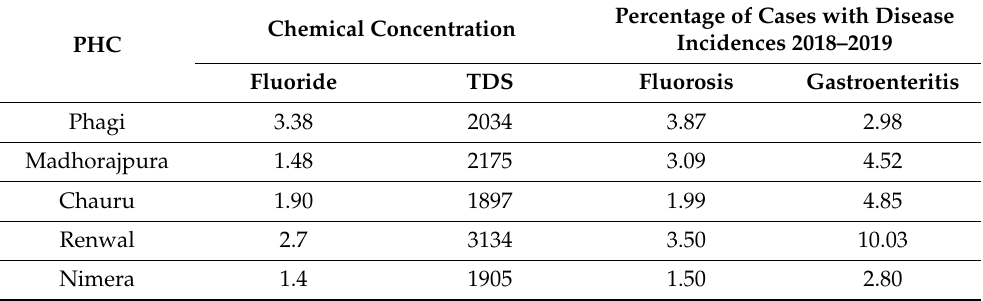
Table 4. PHC wise incidence of diseases and concentration of selected chemicals in groundwater (mg/L).